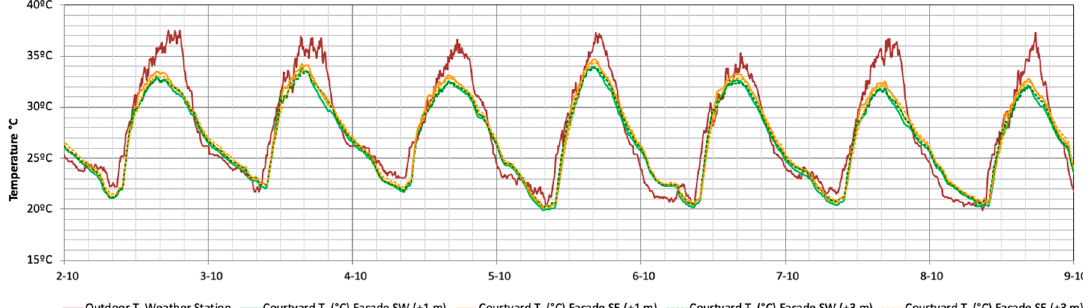
Figure 13. Previous thermal behavior (02–09 October) of case study 2.